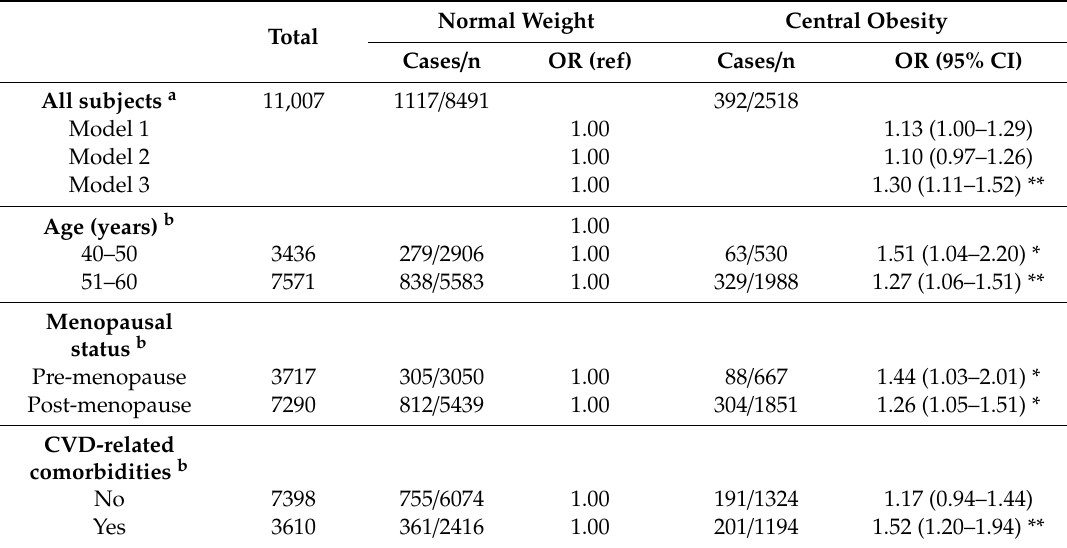
Figure 2. The concentrations of Hcy according to waist circumference (WC) or body mass index (BMI). ( a ) Subjects were divided into two WC categories (normal weight: < 85.0 cm; and central obesity: ≥ 85.0 cm); ( b ) Subjects were divided into three BMI categories (normal weight: ≤ 23.9 kg / m 2 ; overweight: 24.0–27.9 kg / m 2 ; and obesity: ≥ 28.0 kg / m 2 ); ( c ) and ( d ) Stratified by menopause for further analysis. Table 2. Odds ratios (ORs) and 95% confidence internals (CIs) for HHcy associated with waist